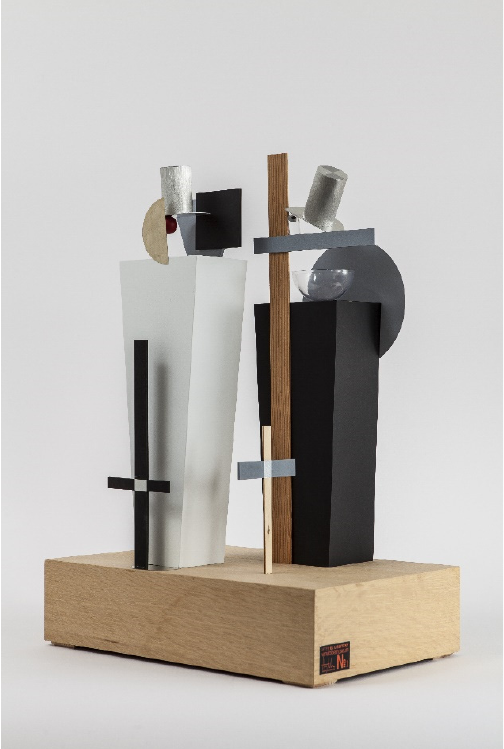
Figure 20. Model after El Lissitzky, ‘The Gravediggers’, 1923, construction by Henry Milner, 2009. Van Abbemuseum. Photo: Perry van Duijnhoven.